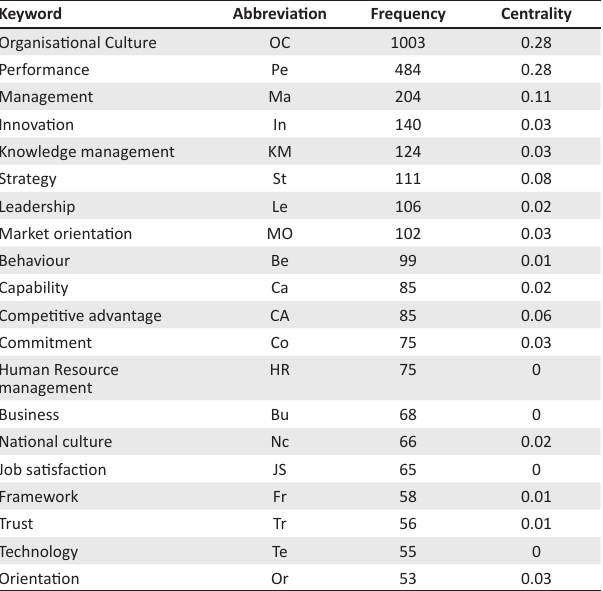
FIGURE 5: Map of the most productive institutions with collaborative links. TABLE 7: The top 20 keywords from